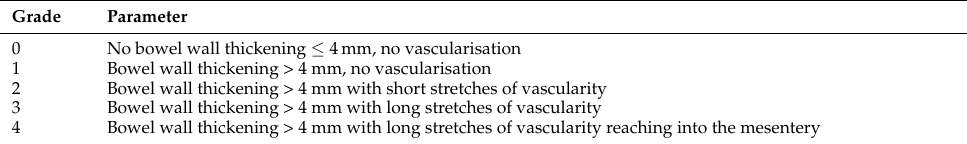
Table 2. Limberg